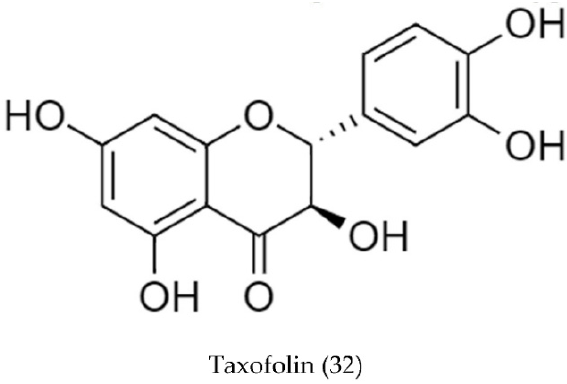
Figure 18. Chemical structures of